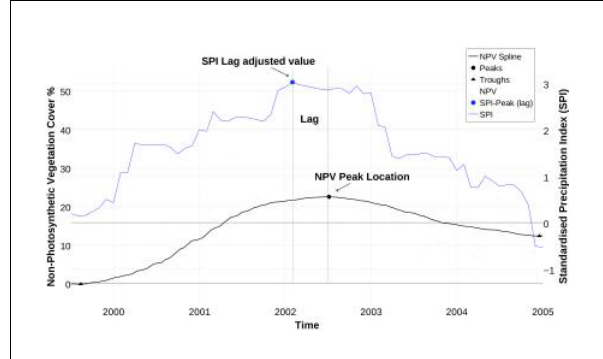
Figure 9. Example of a number of NPV growth cycles across an image subset, their utilisation and growth stages and the divergence and confluence between them as a function of grazing intensity and climate